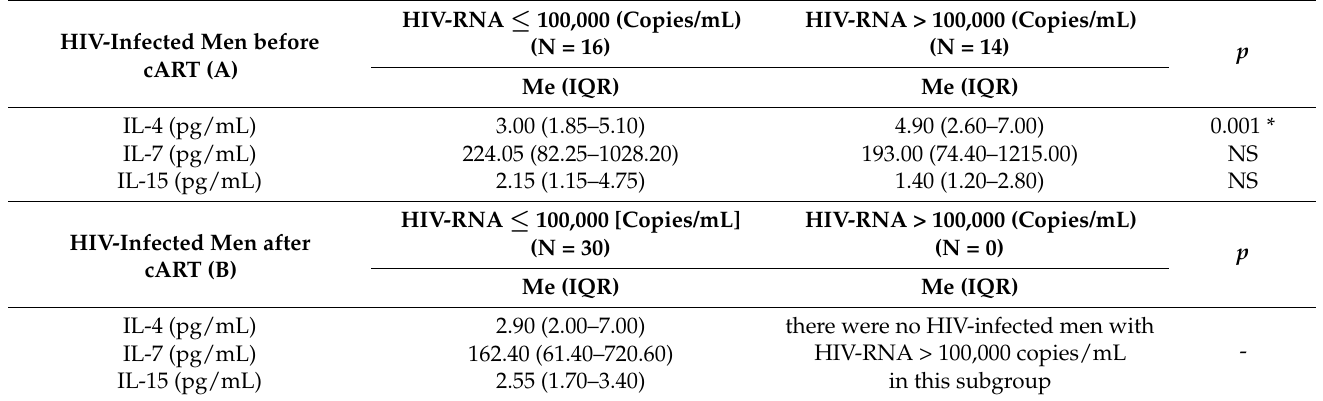
Table 3. Results of IL-4, -7 and -15 before (group A) and after (group B) cART in HIV-infected men by HIV-RNA viral load (below and above 100,000 copies/mL) with statistical